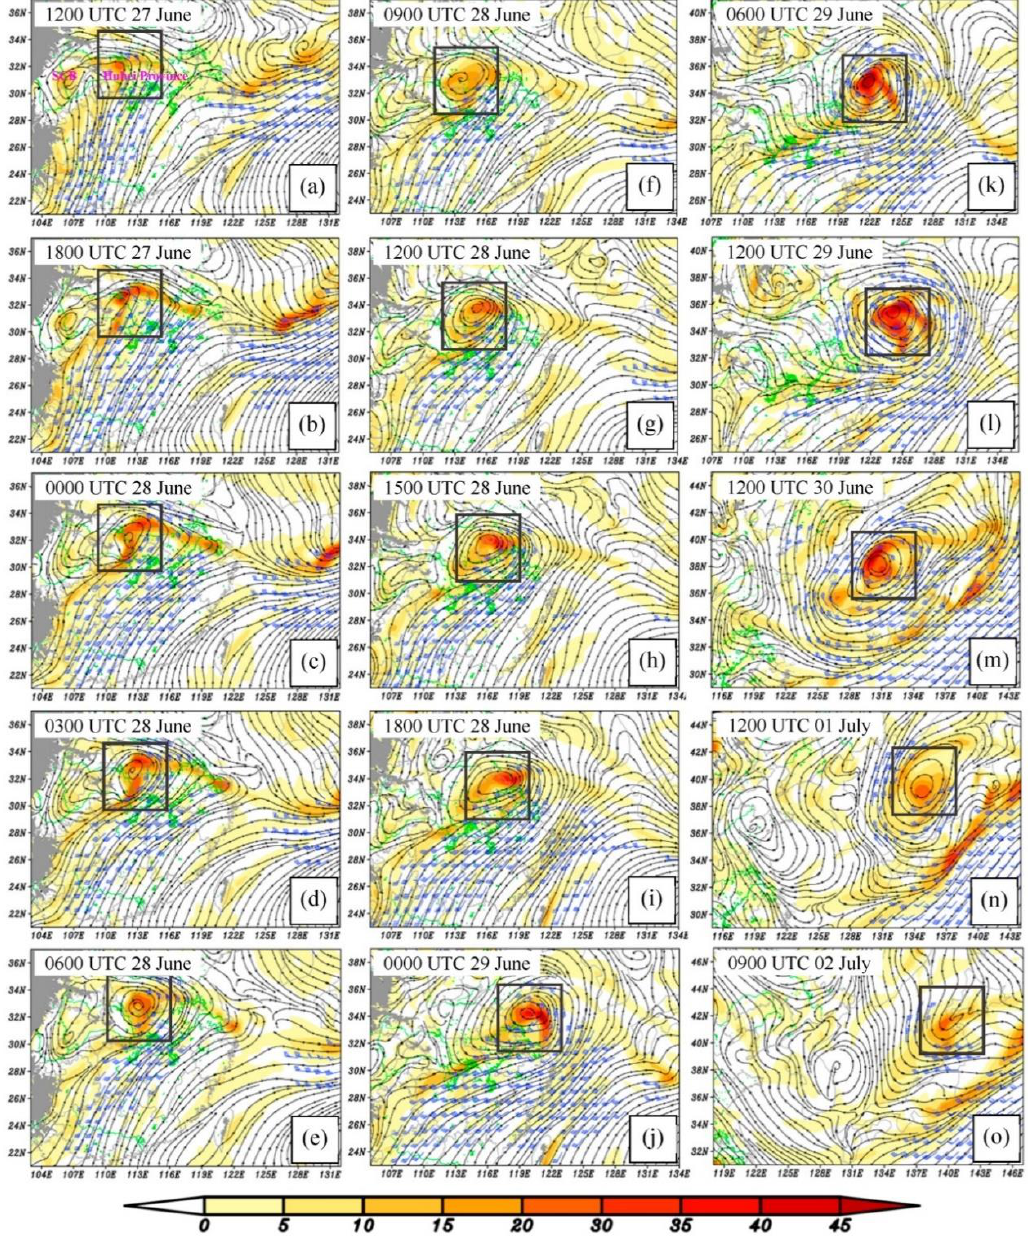
Figure 1. The 850-hPa stream field, vorticity (shading, units: 10 − 5 s − 1 ), and wind with speed above 12 m s − 1 (a full bar represents 4 m s − 1 ), where the grey shading outlines the terrain above 1500 m, and the black rectangles mark the central region of the mesoscale vortex. SCB = Sichuan Basin.